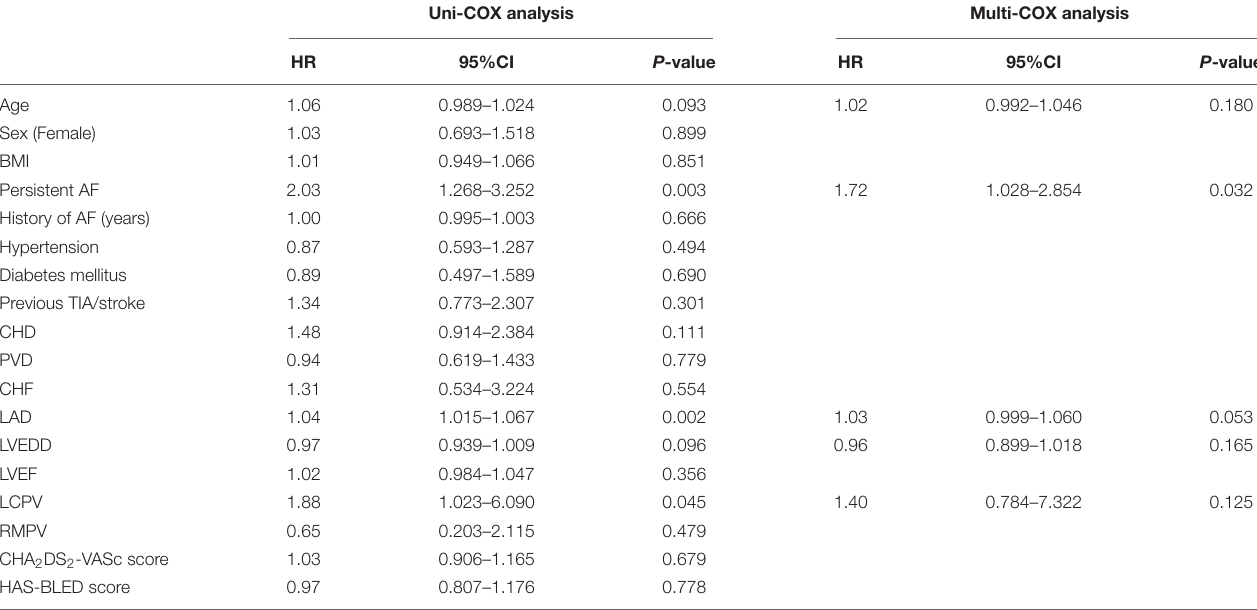
TABLE 3 | Univariate and multivariate Cox regression analysis for predictors of AF